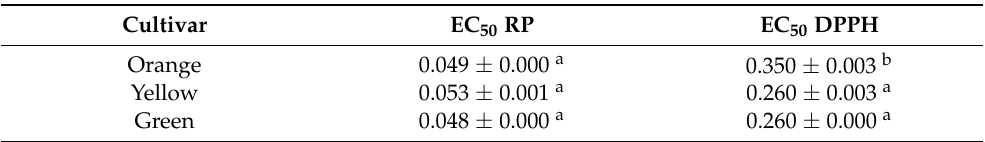
Table 5. EC 50 values (g/mL) measured for the reducing power (RP; FRAP assay) and radical scavenging activity (DPPH assay) of seed extracts from the three cultivars of prickly pear. Values in the same column followed by the same letter are not significantly different at p ≤ 0.05.